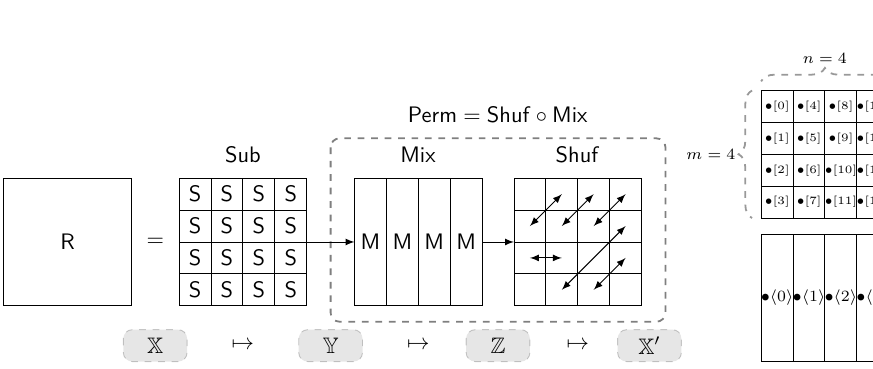
Figure 1: Example of an AES-like round function and two partitions of